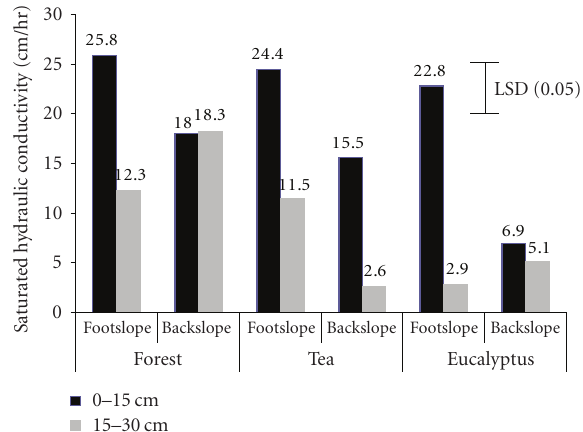
Figure 3: Interaction e ff ect of landscape position and depth on saturated hydraulic conductivity in the di ff erent land